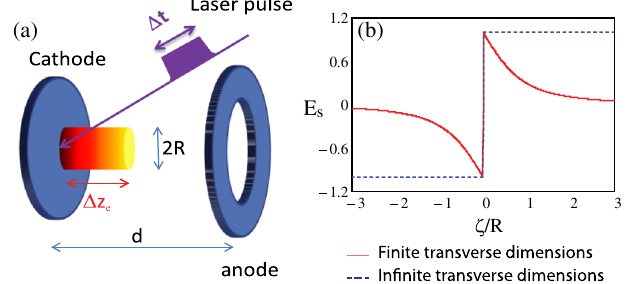
FIG. 1 (color online). (a) Definition of 2D Child-Langmuir parameters. (b) On-axis electric field of a charged disk for infinite (blue dotted) and finite (red dashed) transverse dimensions. The surface charge density is the same in both cases. The on-axis coordinate ζ from the center of the disk is normalized by the disk radius R . The electric field is normalized by σ = 2 ϵ 0